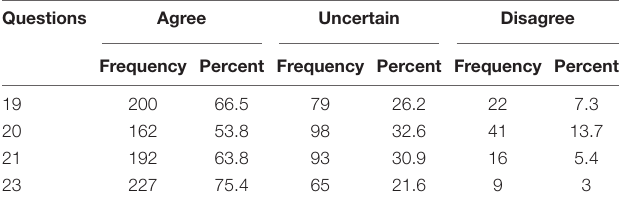
TABLE 4 | Frequency and percent of the questions related the learners’ engagement in of technology integration learning environments.